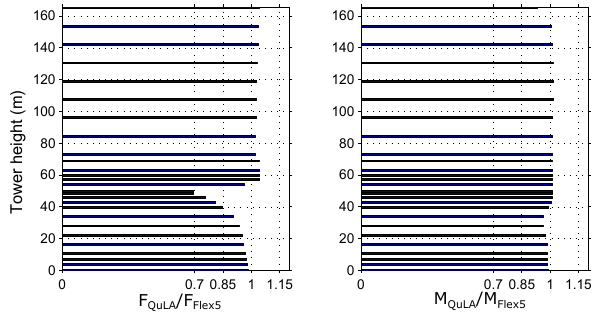
Figure 21. The ratio of the ultimate loads of QuLA to those of Flex5 for load case 6.1 in all sections in the tower and Mono